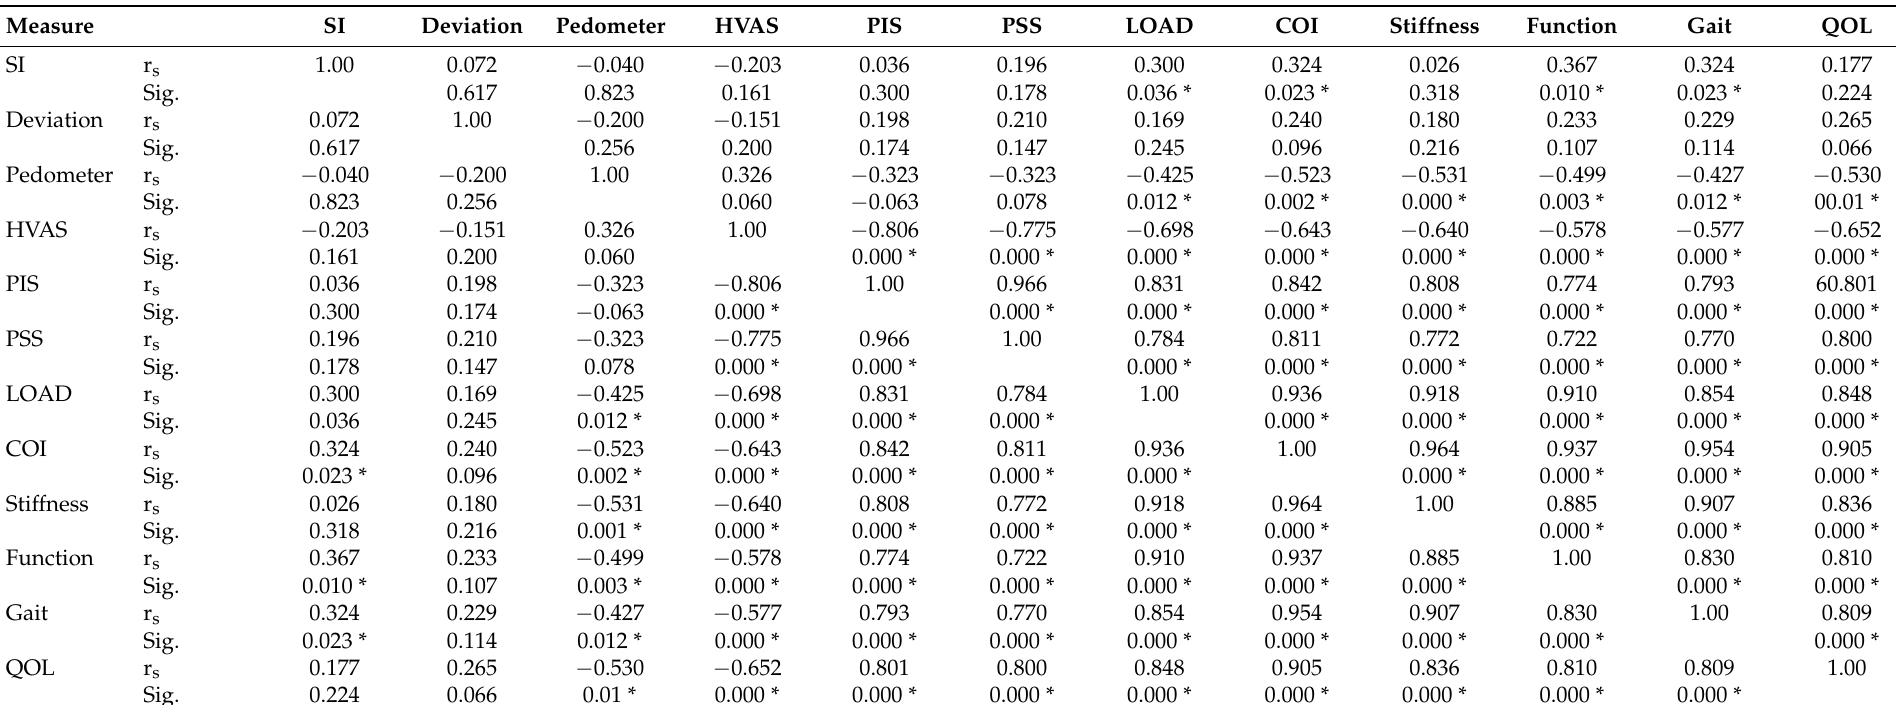
Table 2. Correlations for the cross-sectional cohort. COI: Canine Orthopaedic Index; HVAS: Hudson Visual Analogue Scale; LOAD: Liverpool Osteoarthritis in Dogs; PIS: Pain Interference Score; PSS: Pain Severity Score; QOL: quality of life; SI: symmetry index. *: indicates significant